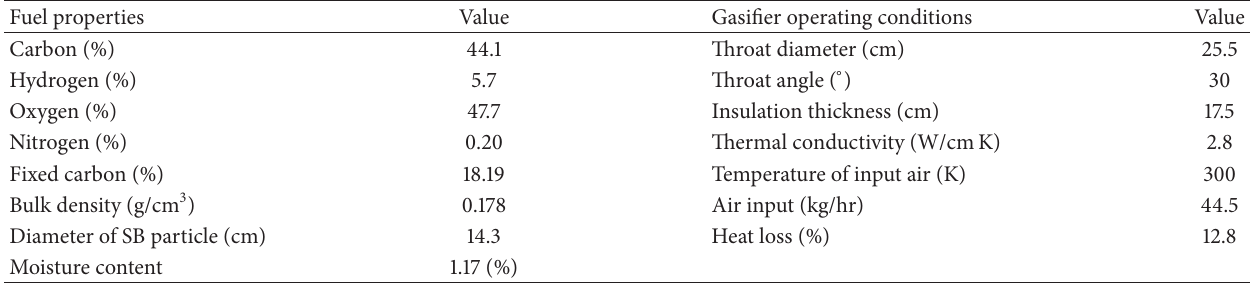
Table 2: Parameters used during gasification simulation.